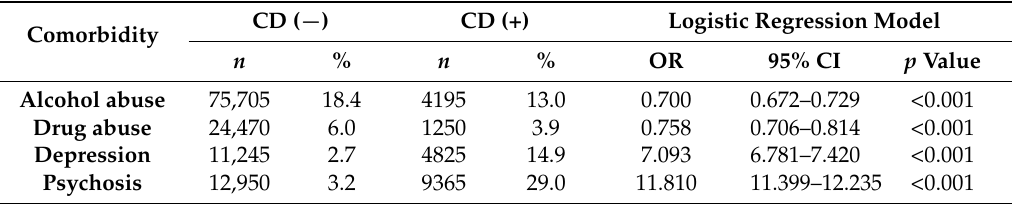
Table 2. Association of comorbidities in patients with conduct